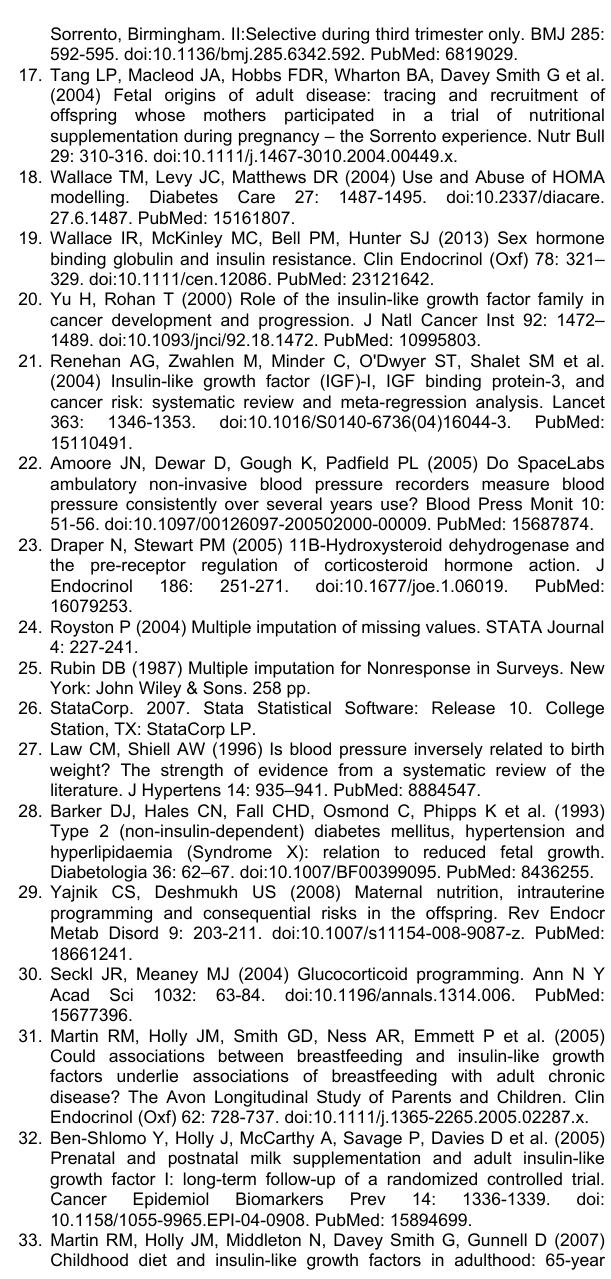
Figure S1. Flow Diagrams showing maternal participation in original Sorrento trial and offspring follow